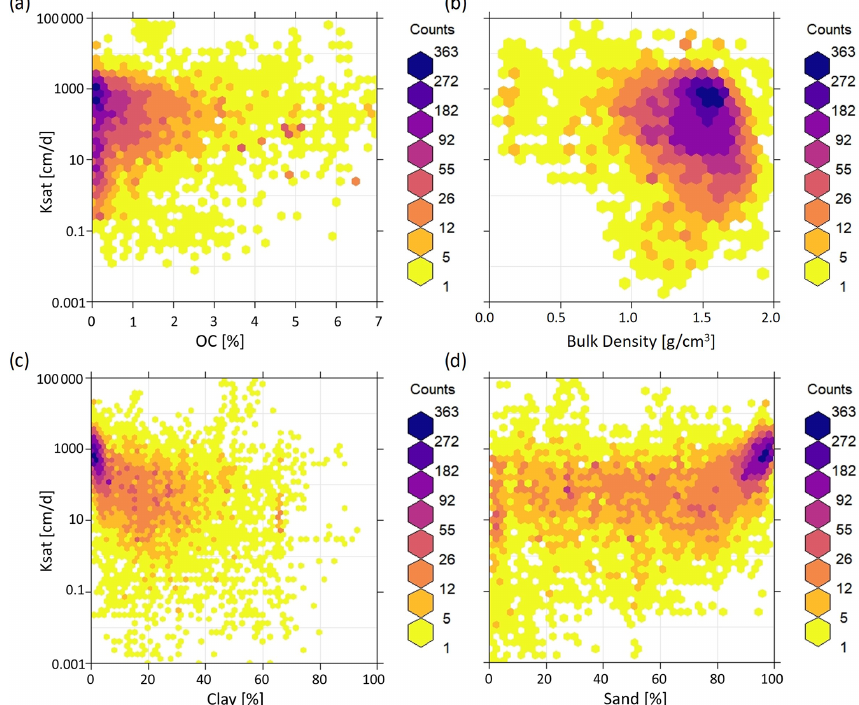
Figure 4. Partial correlation between K sat and (a) soil organic carbon OC (%), (b) bulk density (gcm − 3 ), (c) clay (%), and (d) sand content (%) as heat maps. K sat decreases with increasing clay content and bulk density, and increases with sand content. The color of each hexagonal cell shows the number of the measurements in each cell.